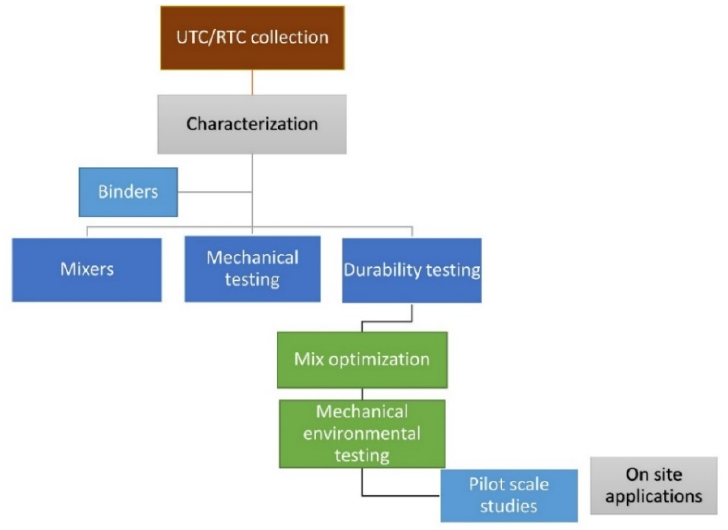
Figure 3. Excavated soils recovery process (RTC = rural trench cuttings; UTC = urban trench cut- tings).